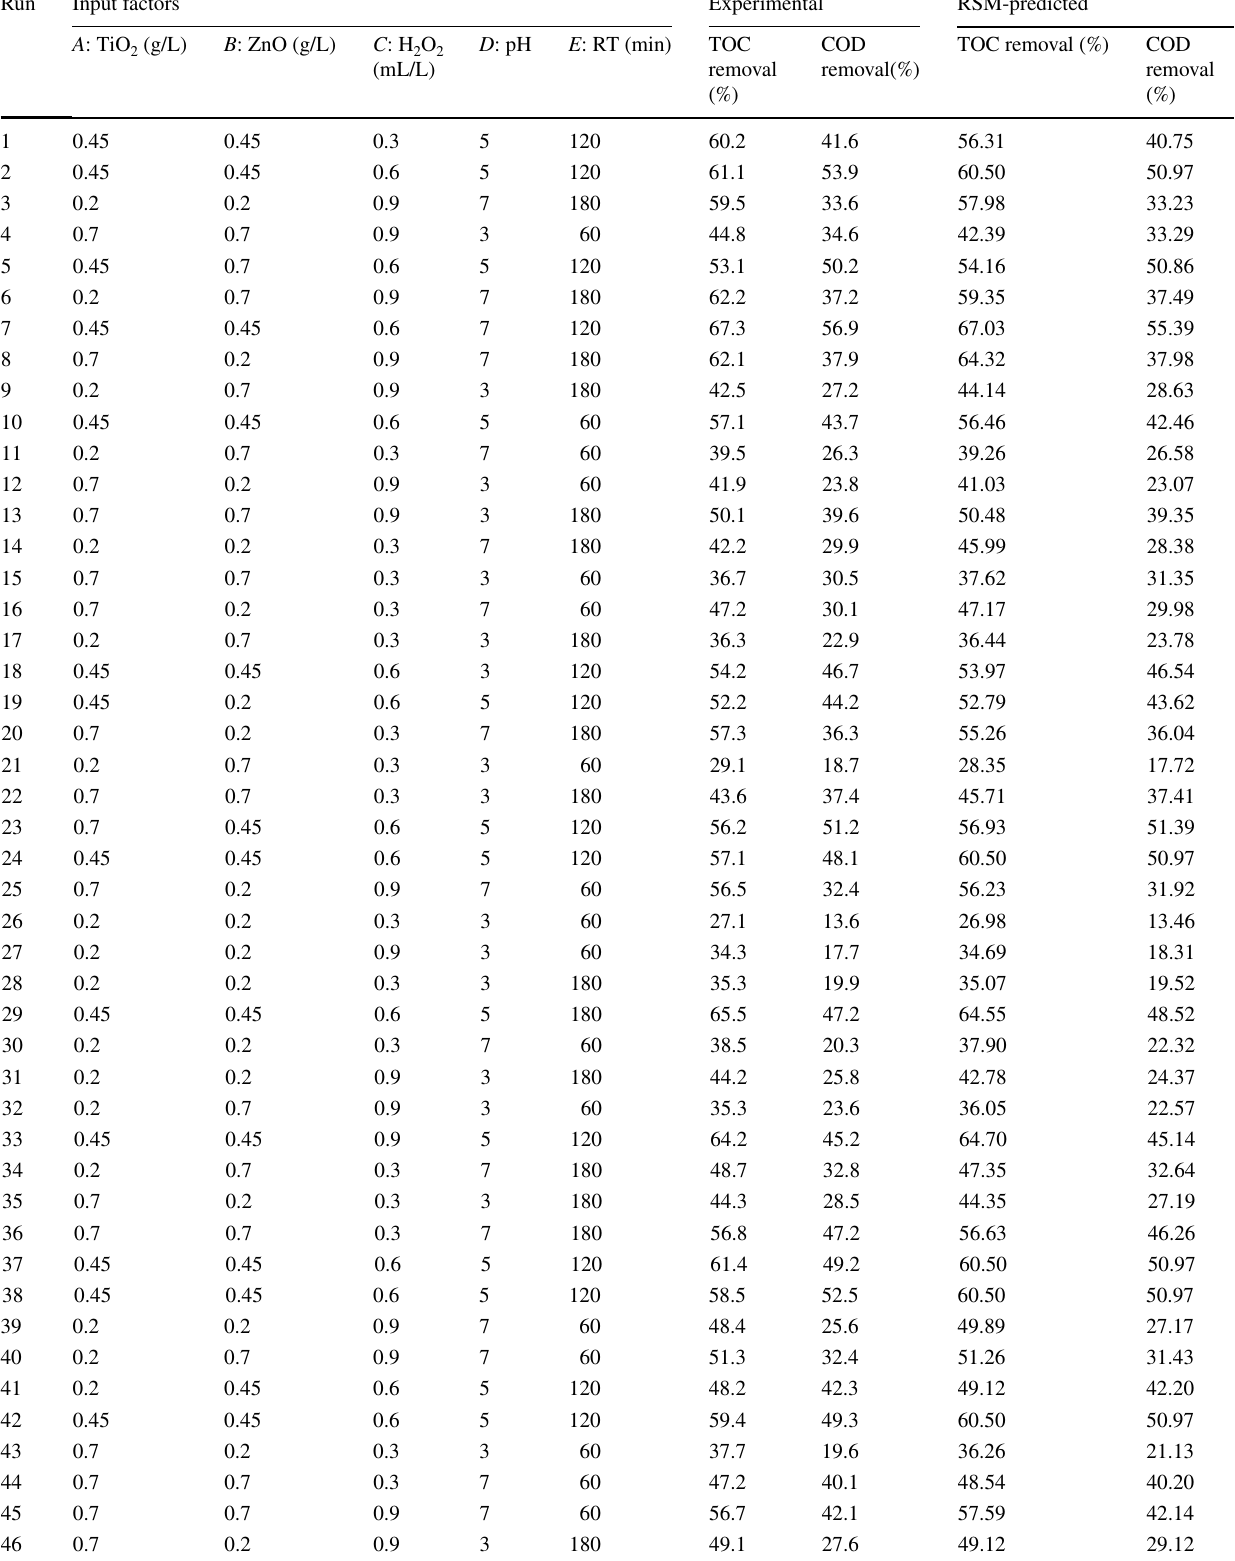
Table 2 Five-factor central composite design (CCD) matrix; input factors at actual levels and the corresponding experimental and predicted